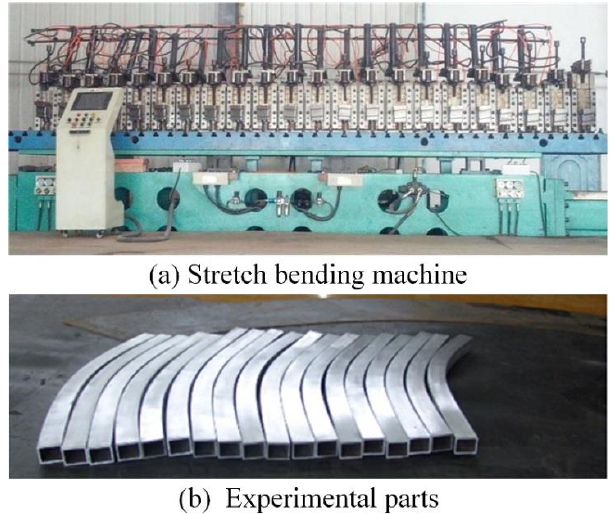
Figure 8. The FMD stretch bending process. ( a ) Stretch bending machine. ( b ) Experimental parts.